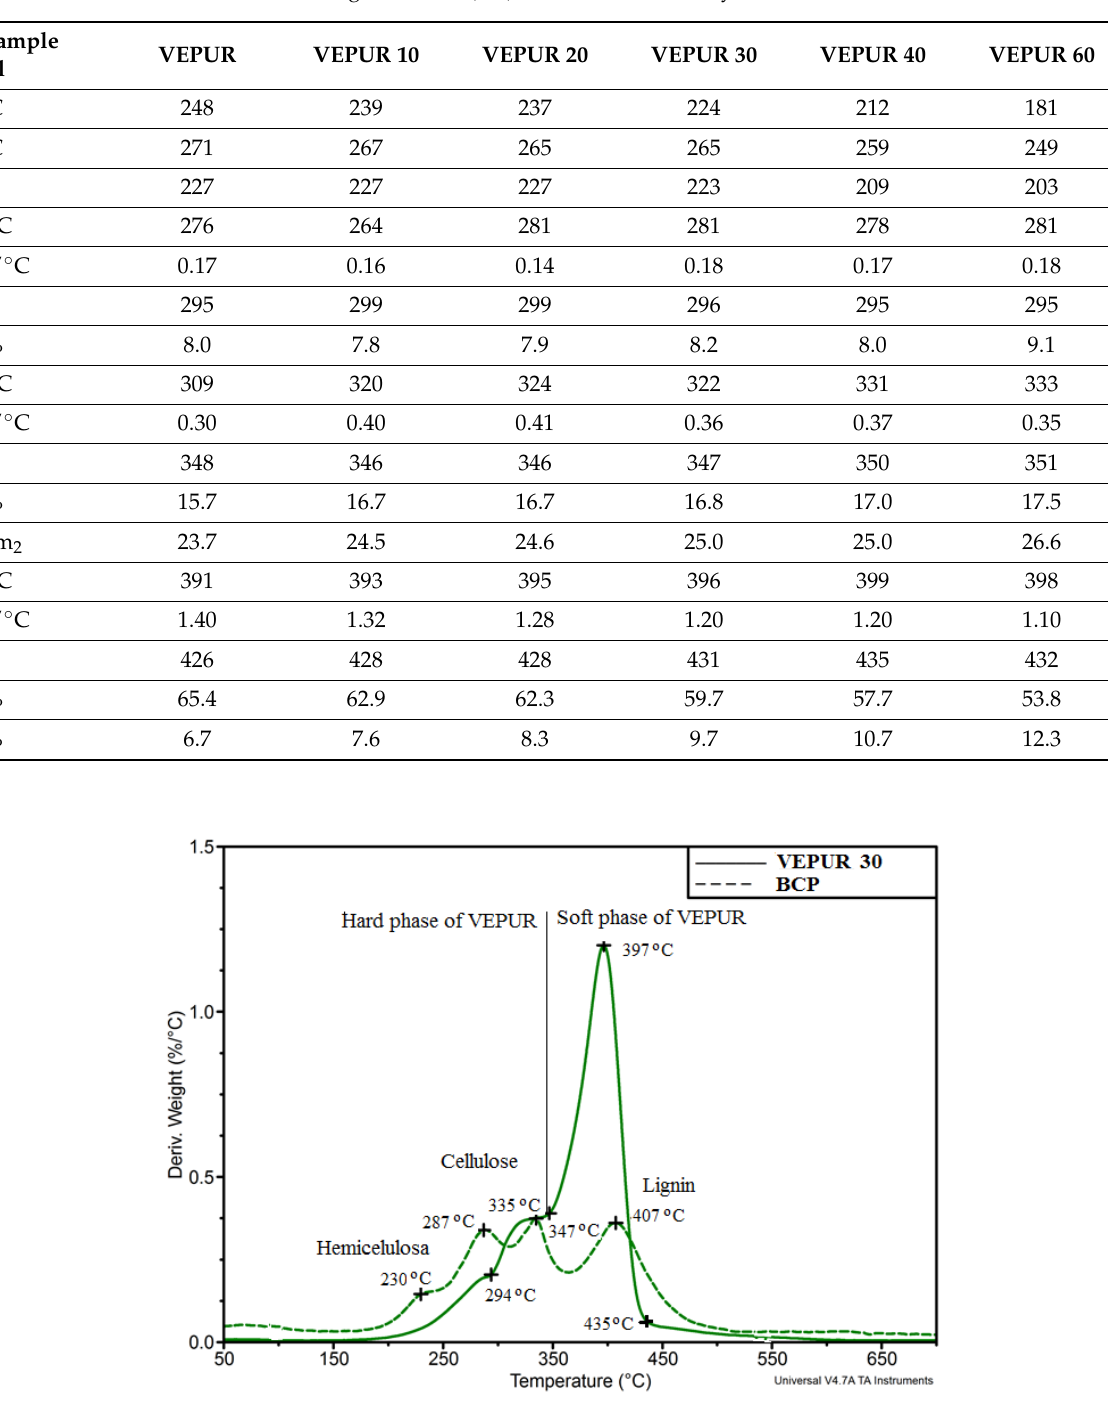
Table 8. Results of thermogravimetric (TG) and DTG curve analysis of foams.